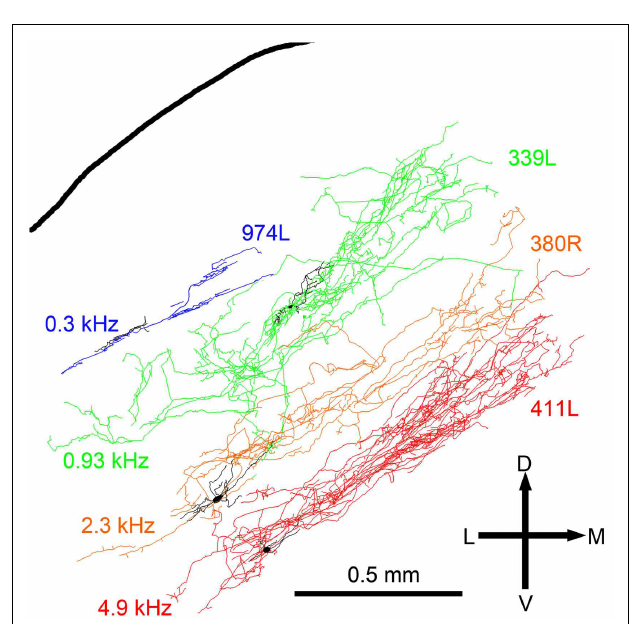
FIGURE 8 | Reconstructions of the intrinsic axons (blue, green, orange, and red respectively) and dendrites (black) of four filled cells superimposed at the appropriate depth below the IC surface and arranged in order of CF (shown to the left).